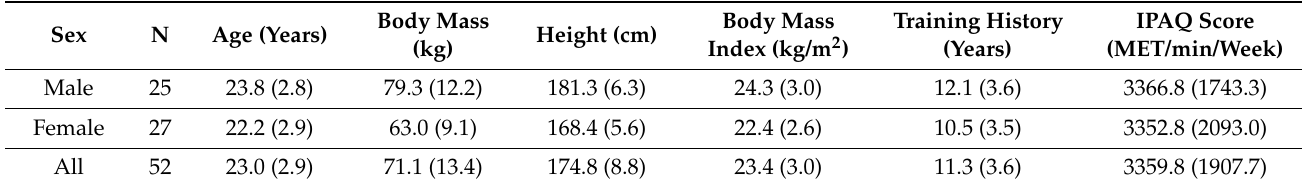
Table 1. Main characteristics of the